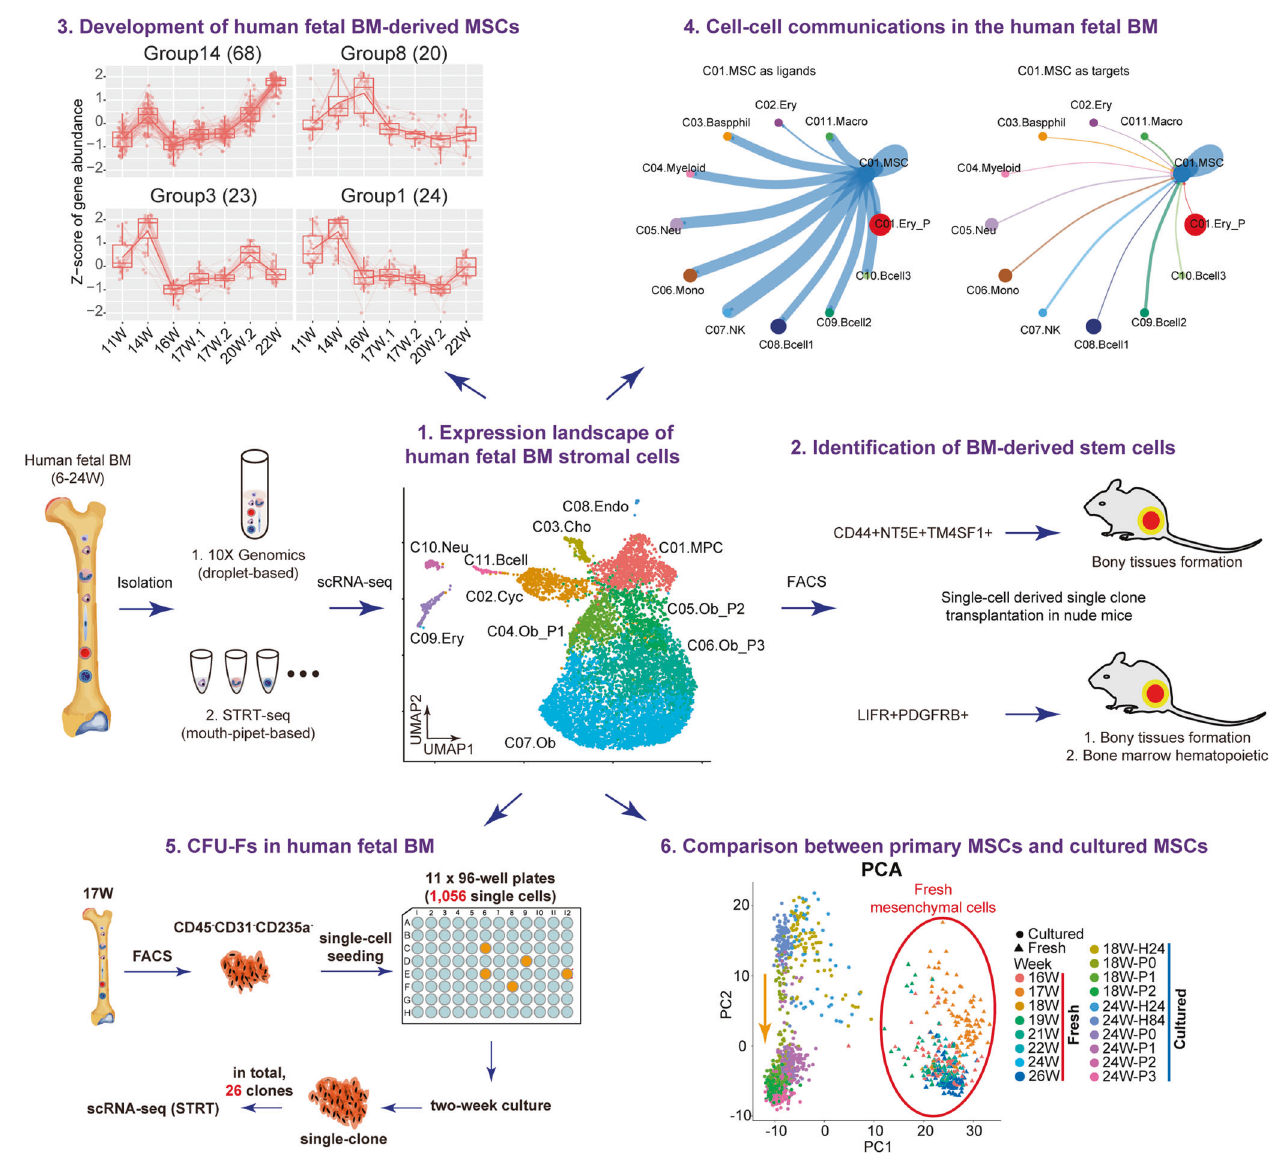
Fig. 7 A mechanism and illustration picture of this study between primary MSCs and cultured MSCs. The fresh MSCs were endowed with multiple functions including extracellular struc- ture organization, collagen biosynthesis and blood vessel development, which were compatible with the characteristics of MSCs. In contrast, the cultured MSCs underwent the ‘ active proliferation – differentiation – senescence ’ processes. Of note, the signature of fresh MSCs is quite different from that of culture- expanded MSCs (Fig. 6). In vitro expansion that could preserve the original disposition and progenitor function of MSCs would be a great help for MSC therapy. In a recent study, 38 Chan et al. de fi ned a cluster of skeletal stem cells (SSCs) in human embryos, which could differentiate into cartilage and bone/stroma. We downloaded their scRNA-seq dataset and integrated it with our dataset. However, compared with our current observation of MSCs in human fetal BM, there was no speci fi c cell population that speci fi cally expressed the identi fi ed MSC markers in their dataset (Supplementary Fig. 7a, b), indicating the different lineages between the MSCs identi fi ed in this study and the SSCs they found.